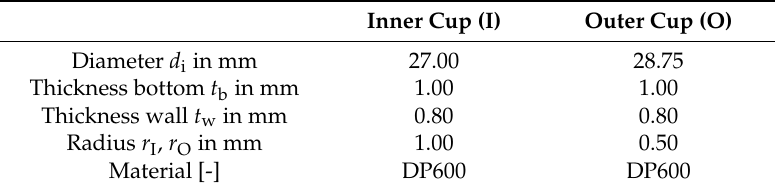
Figure 6. Axial symmetric view of the actuator’s fem model. Table 4. Geometric parameters of the actuator.